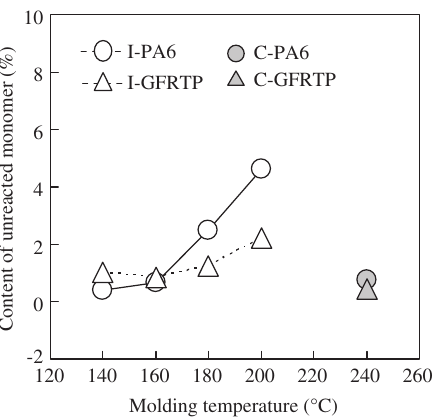
Figure 9 Content of uncreated monomer of I-CFRTP and C-CFRTP.